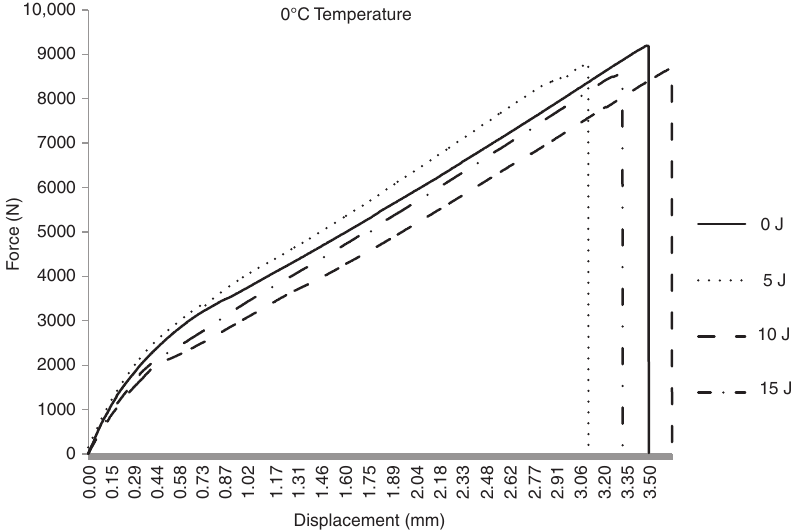
Figure 9: Effects of different impact energy values on load-displacement response at the 0 ° C temperature level.